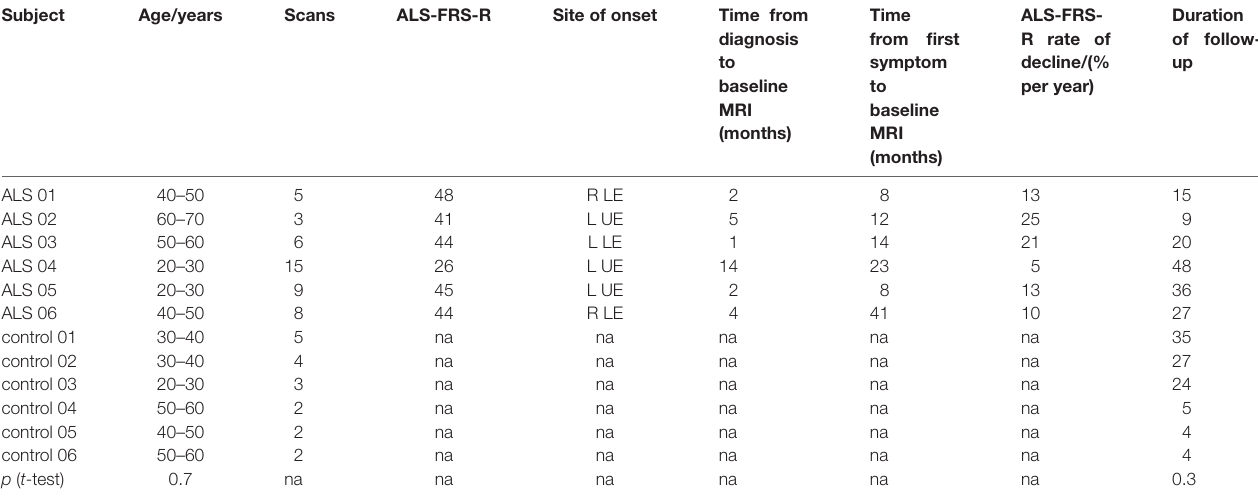
TABLE 1 | Baseline characteristics of patients and